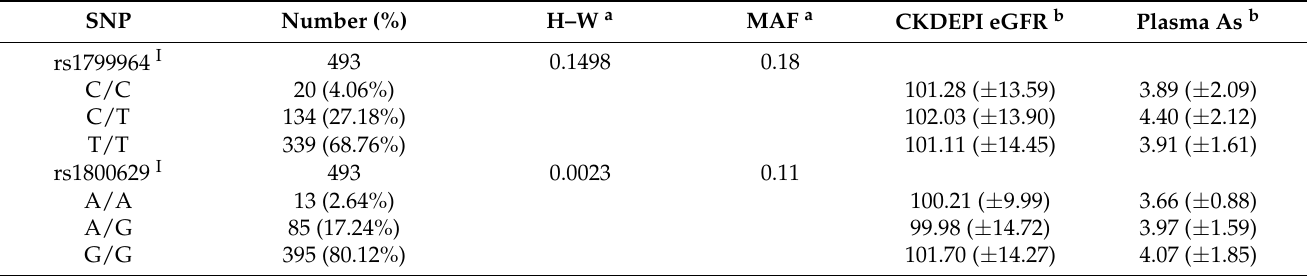
Table 2. CKDEPI eGFR and plasma As levels of the study population according to each SNP